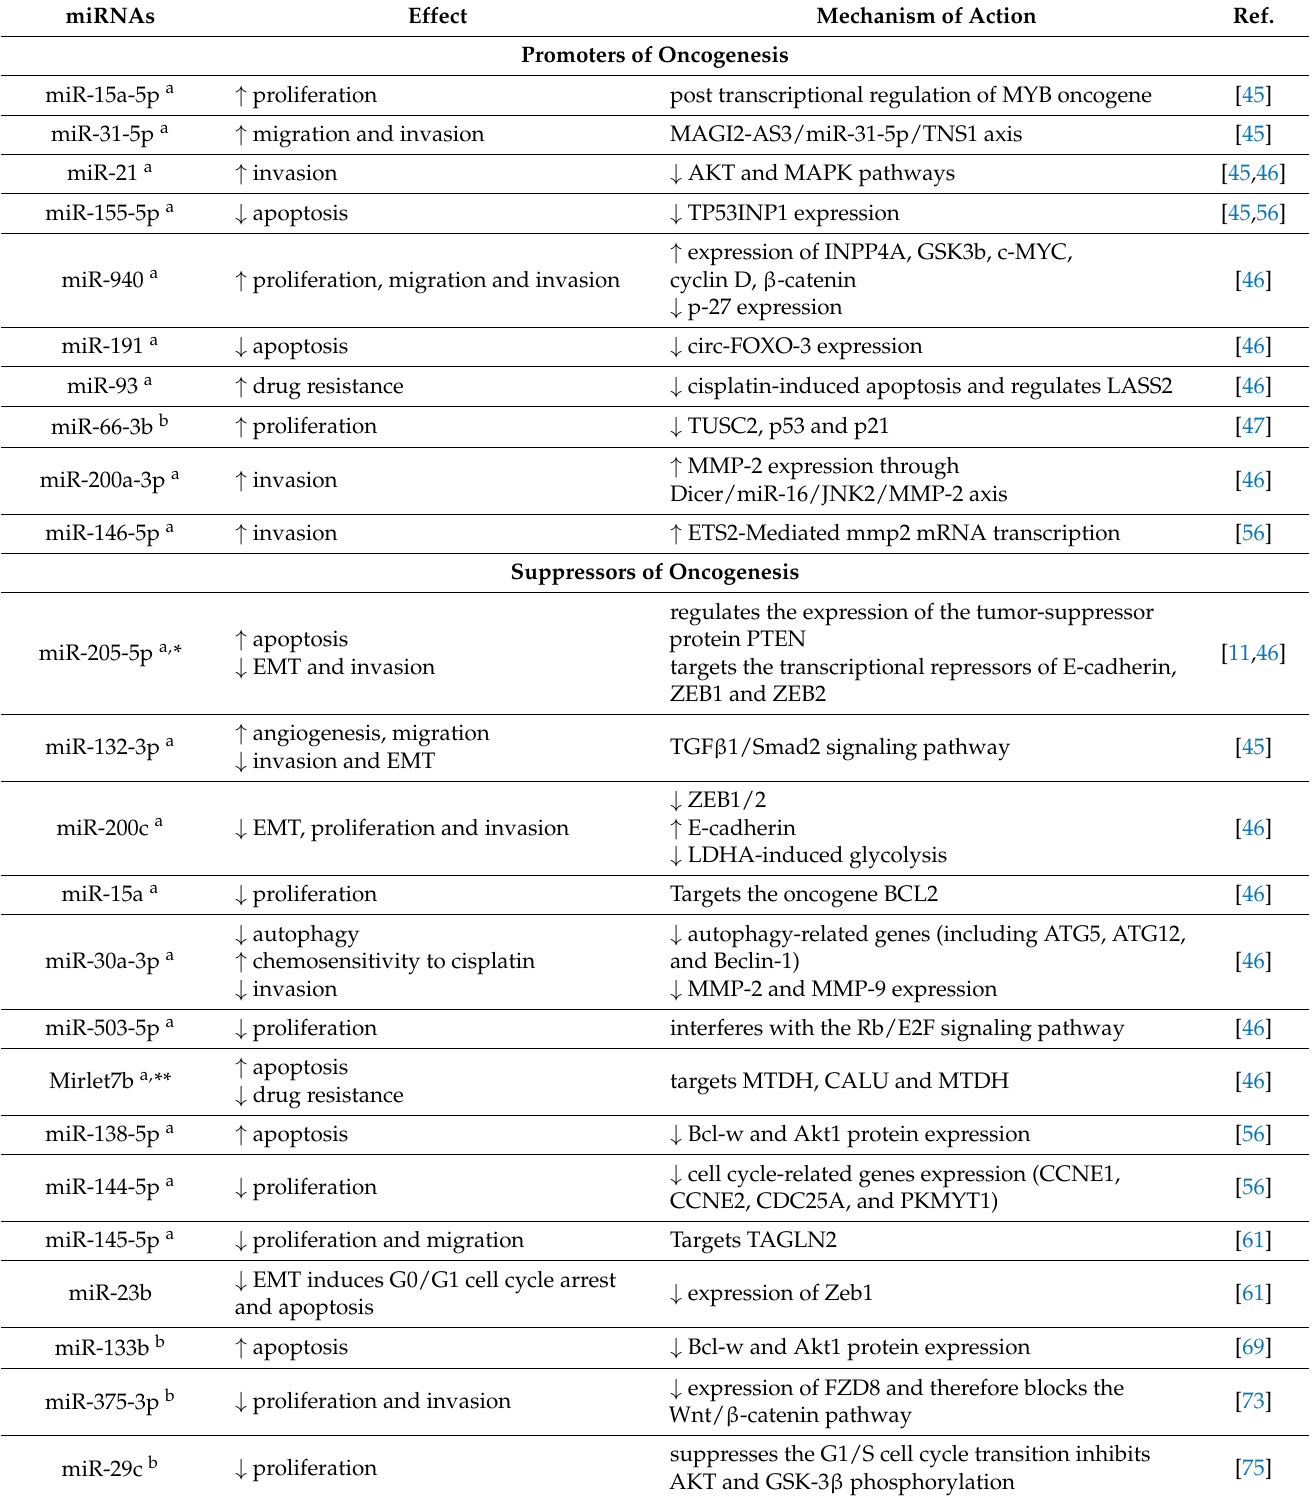
Table 2. Molecular pathways of EV miRNA biomarkers in bladder cancer pathogenesis. miRNA Extracellular Vesicle Biomarkers in Bladder